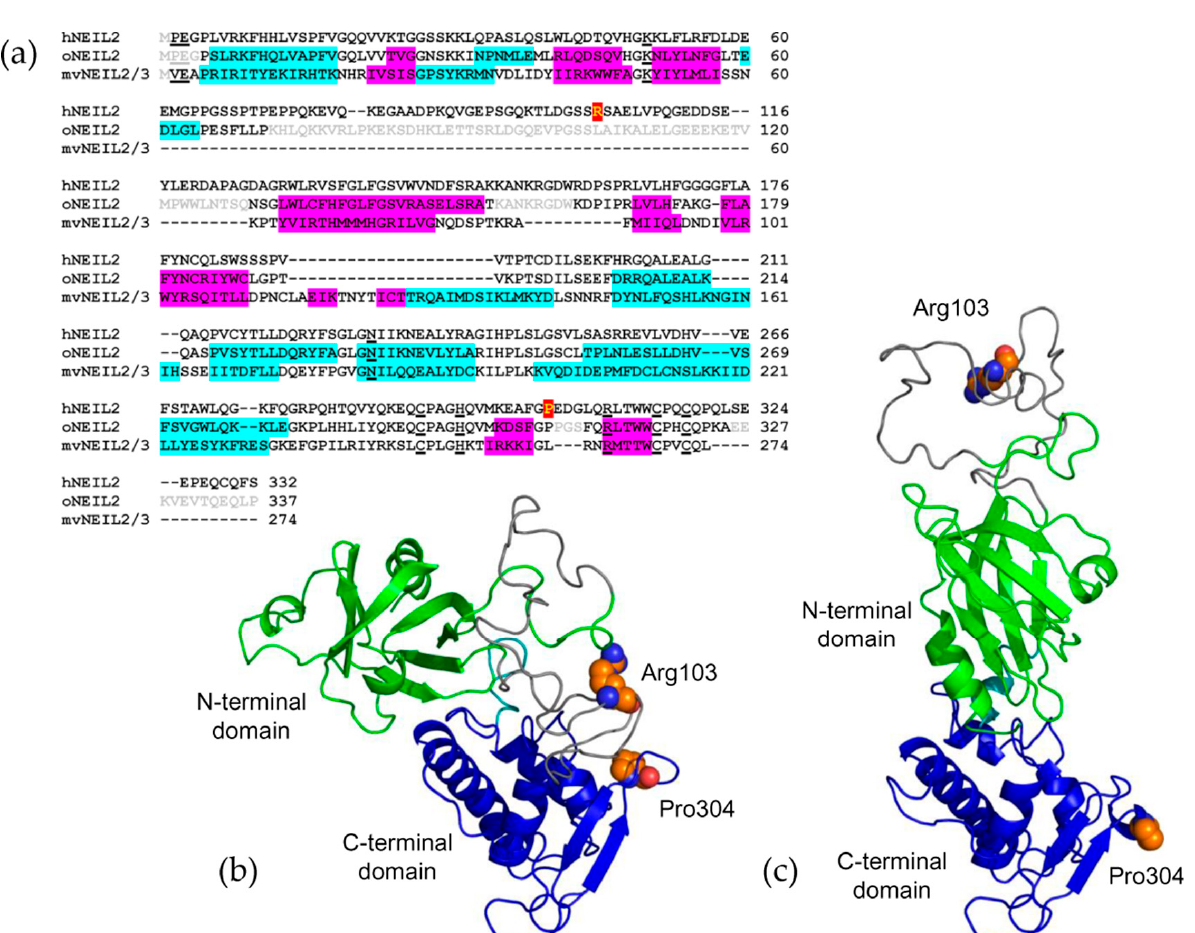
Figure 1. Structural models of hNEIL2. ( a ) Alignment of hNEIL2, oNEIL2, and mvNEIL2/3. α -Helices in the oNEIL2 and mvNEIL2/3 structures are highlighted cyan, β -strands are shown in magenta. The residues missing from the X-ray structures are shown in grey. The key residues participating in catalysis, DNA binding, and Zn 2+ ion coordination are underlined. Arg103 and Pro304 in the human sequence are highlighted red. ( b ), Homology model of the closed conformation of hNEIL2 based on the mvNEIL2/3 template (4MB7 [15] ). ( c ) Homology model of the open conformation of hNEIL2 based on the oNEIL2 template (6VJI [14]). In ( b , c ), the N-terminal domain of hNEIL2 is shown in green, the C-terminal domain, in blue, the disordered loop, in grey, and the interdomain linker is in turquoise.